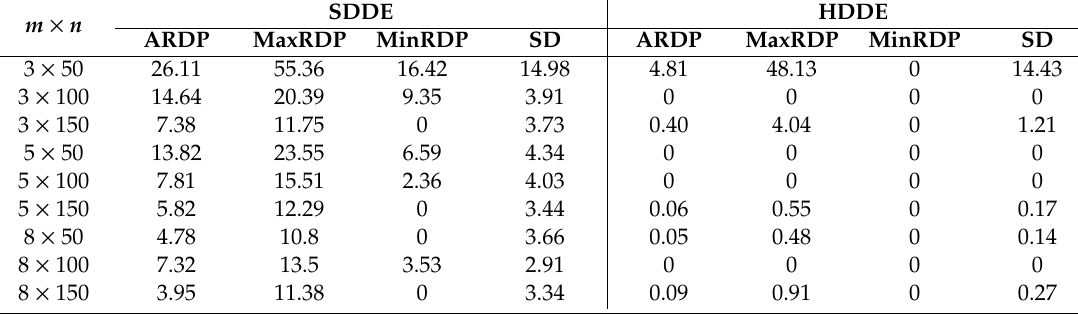
Table 7. Improvement e ff ect of the HDDE